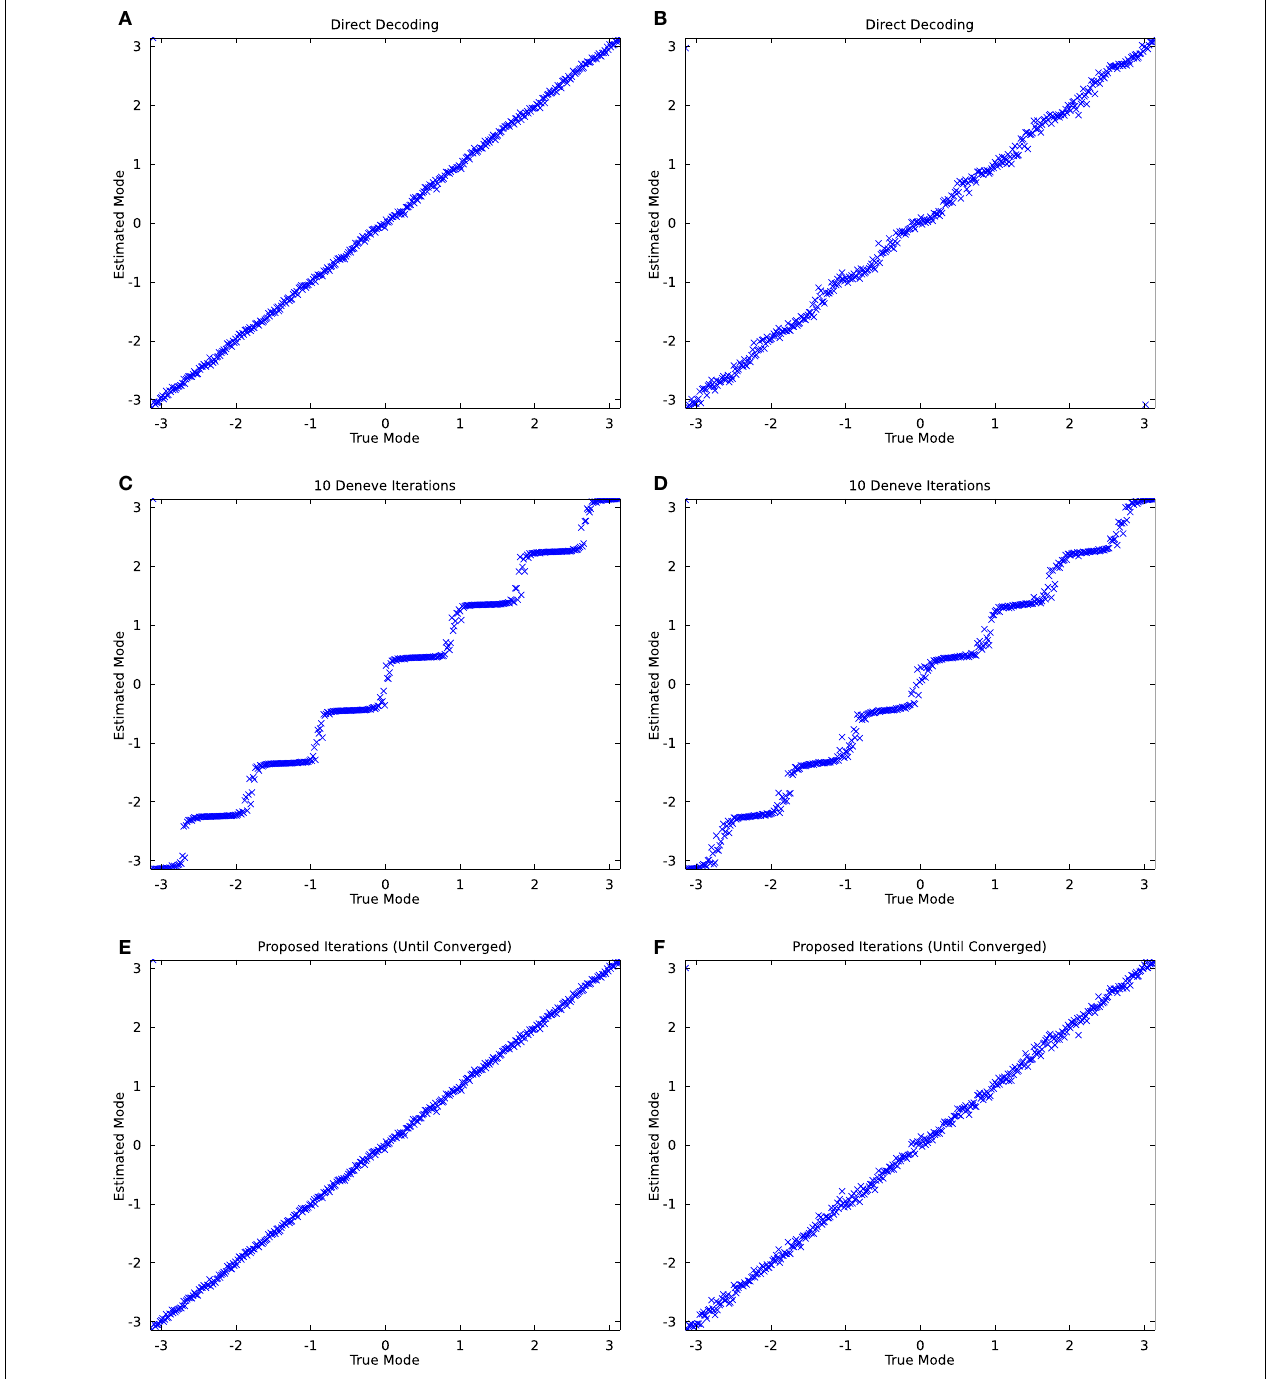
FIGURE 14 | Simulation of orientation information with varying standard deviations . (A,C,E) : results for (cid:27) = half the decoding window, 200 samples; (B,D,F) for (cid:27) = 1.5 times the decoding window, 1800 samples. (A,B) : decoding without iterations; (C,D) results using 10 iterations of (9); (E,F) results using the proposed